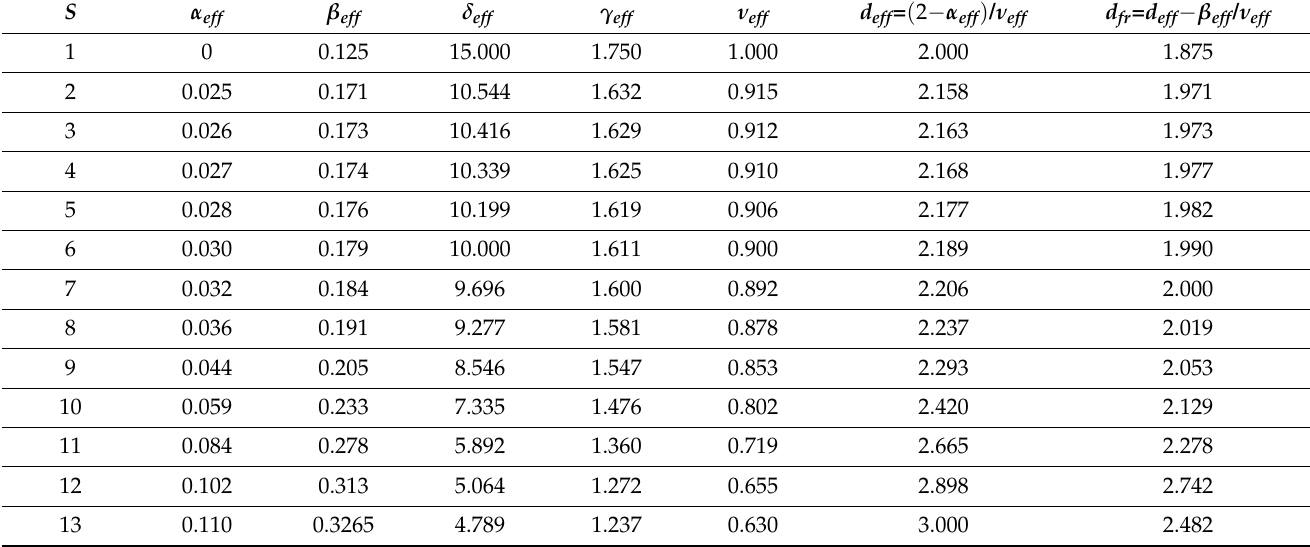
Table 1. Effective fractal, spatial dimensions and the critical